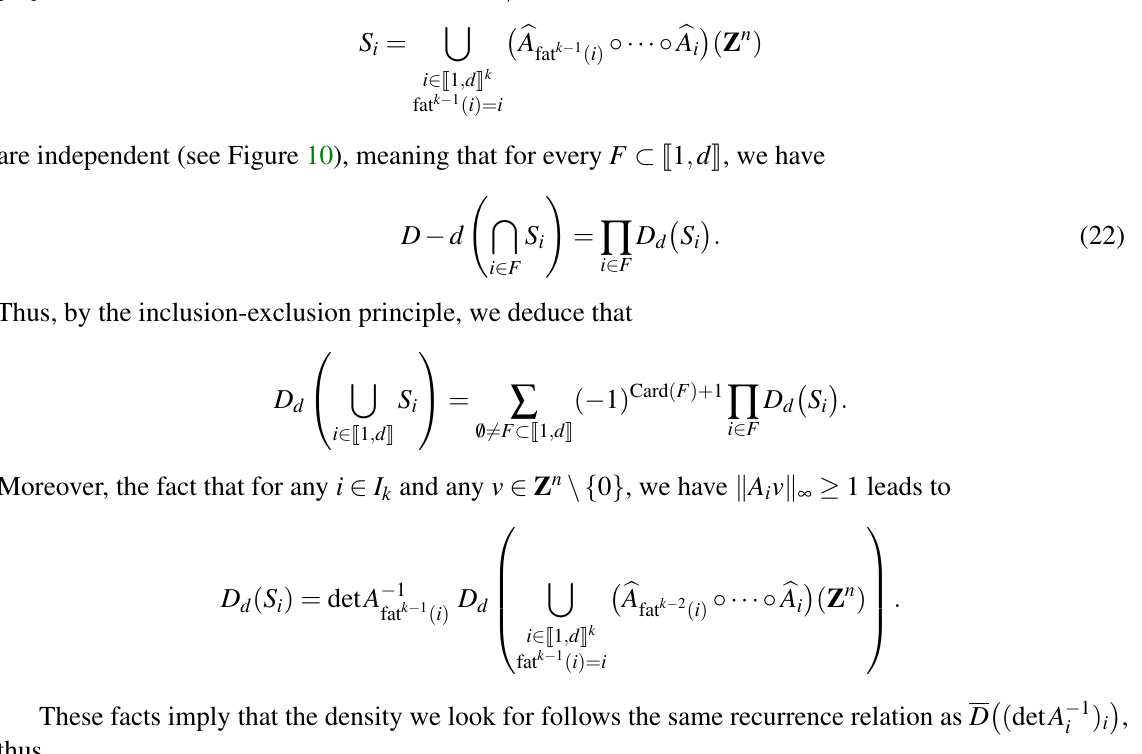
Figure 10: Calculus of the density of the image set at the level k according to the density of its sons. projects on a dense subset of the torus R n Card I k / Z n Card I k , then the events x ∈ S i ,